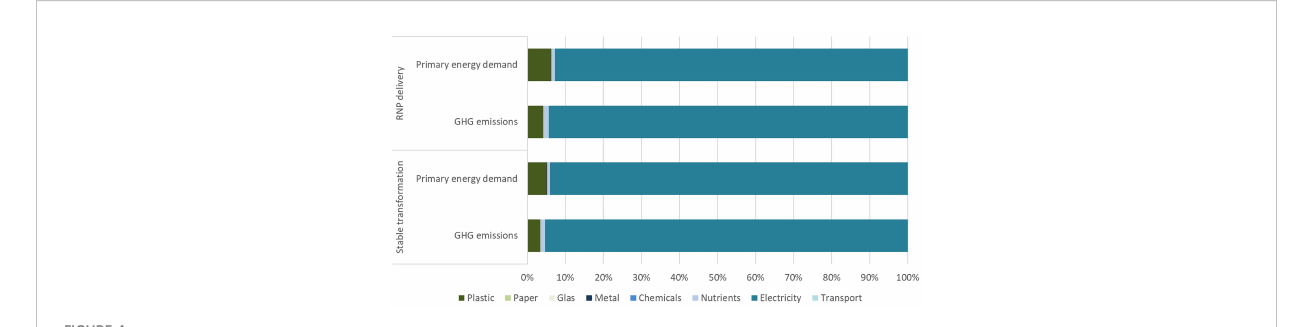
FIGURE 4 Shares of environmental impacts by auxiliaries for stable transformation and RNP delivery.